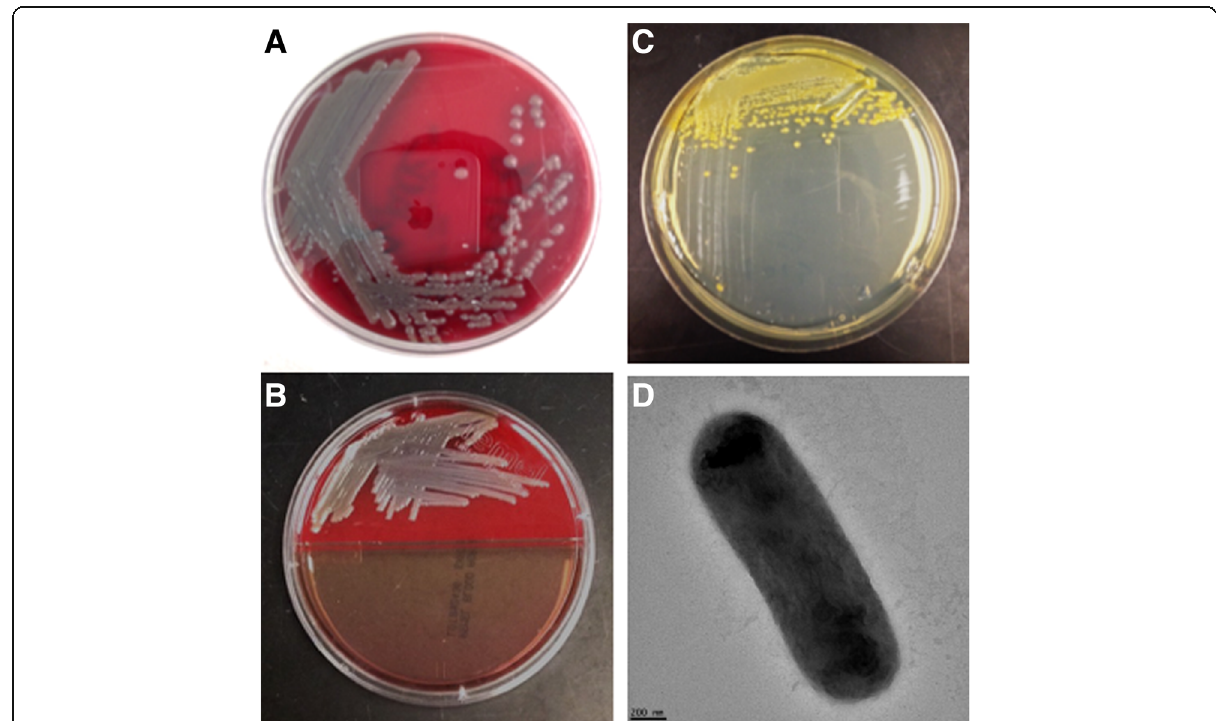
Fig. 1 Demonstration of cell growth, pigment production and micrograph. a Em3 growing on SBA medium; b Demonstration of Em3 grown on SBA medium (control, up part) and MacConkey agar (low part). c Pigment production in Em3 grown on TSA agar. d Scanning electron microscopy image of